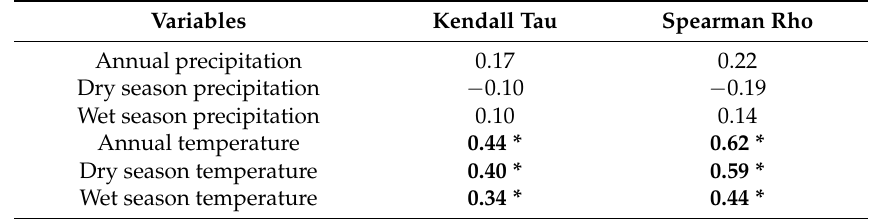
Table 2. Trend analysis of climate, hydrological and forest disturbance variable from 1990 to